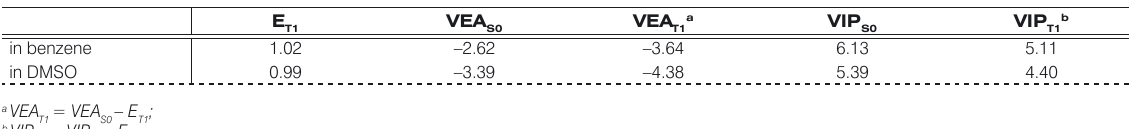
Table 1. Lowest triplet excitation energy (E , in eV), vertical electron affinity (VEA, in eV) and vertical ionization potential (VIP, in eV) of indigo in T1 benzene and DMSO. E